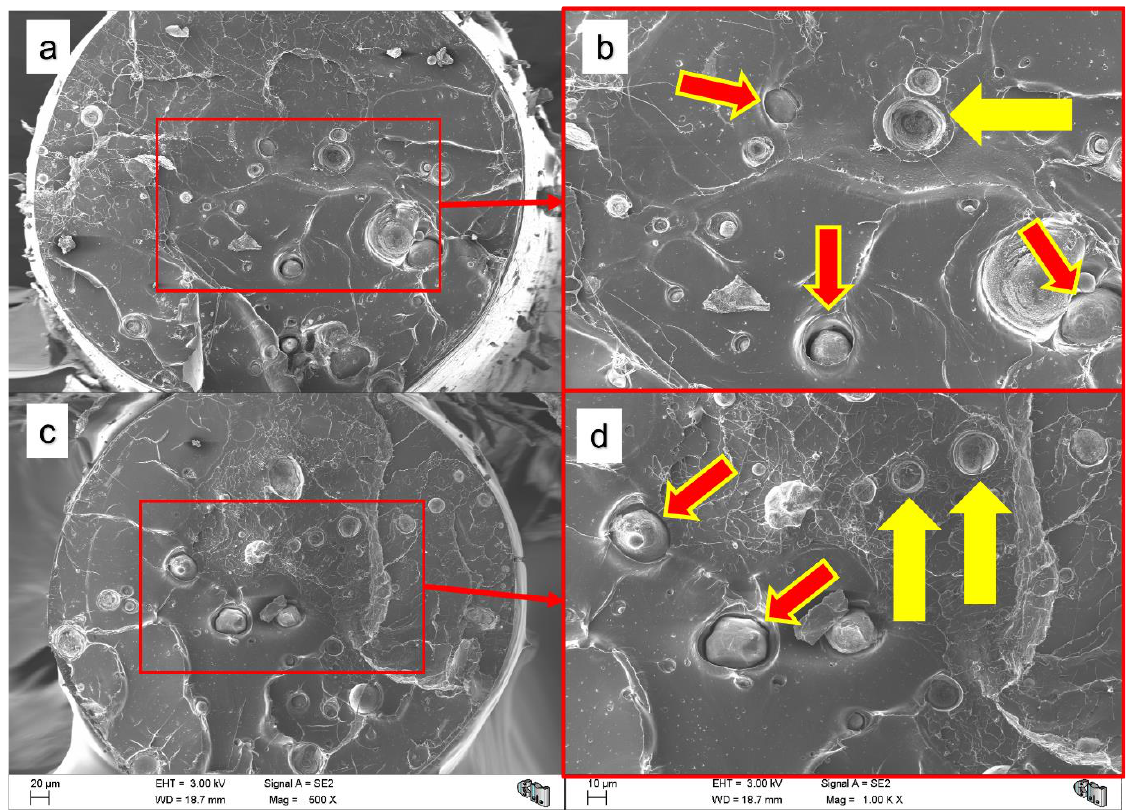
Figure 12. SEM fractographies of PLA-5Mg after tensile tests at 1 mm/min. (a) PLA-Mg tensile test fracture surface, (b) detail of fracture surface. (c) Another PLA-Mg tensile test fracture surface and (d) a detail of it. Arrows indicate that the Mg particles detached from the PLA-matrix after a tensile test.